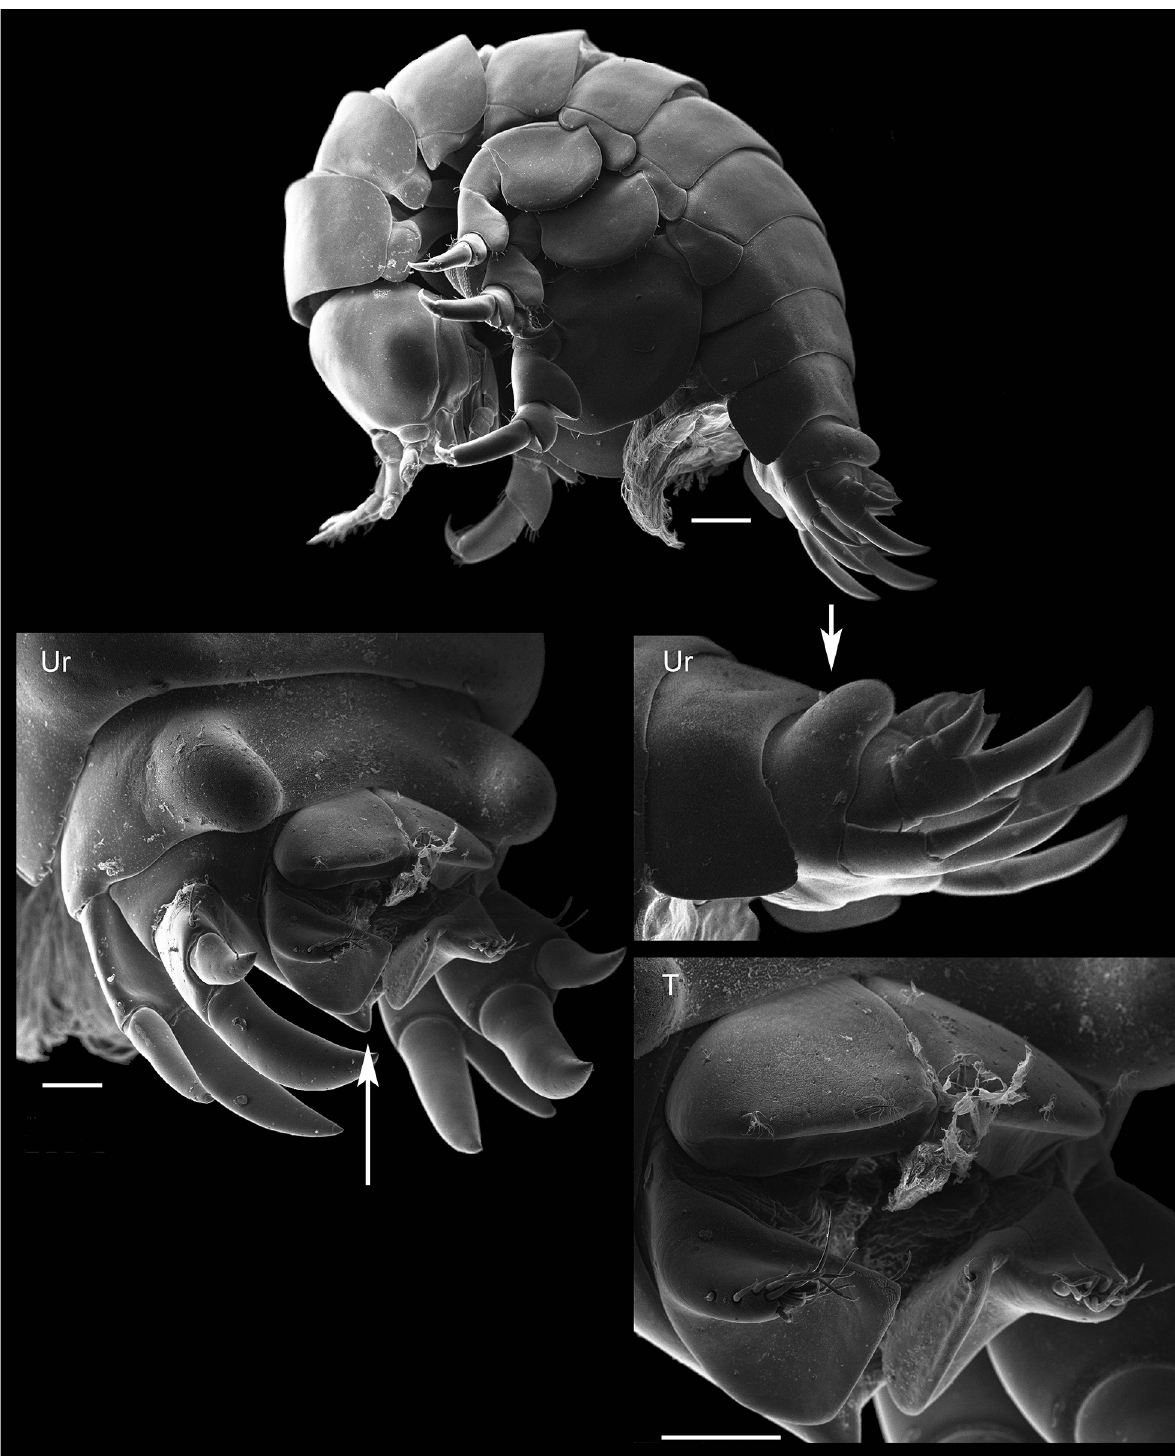
Figure 3. Bircenna hinojosai sp. nov. paratype SEM, gender indet. 6.7 mm, ZMH-K 45991, Bicheno, Tasmania, Australia. Scale bars: Habitus, 200 µm; Ur, 100